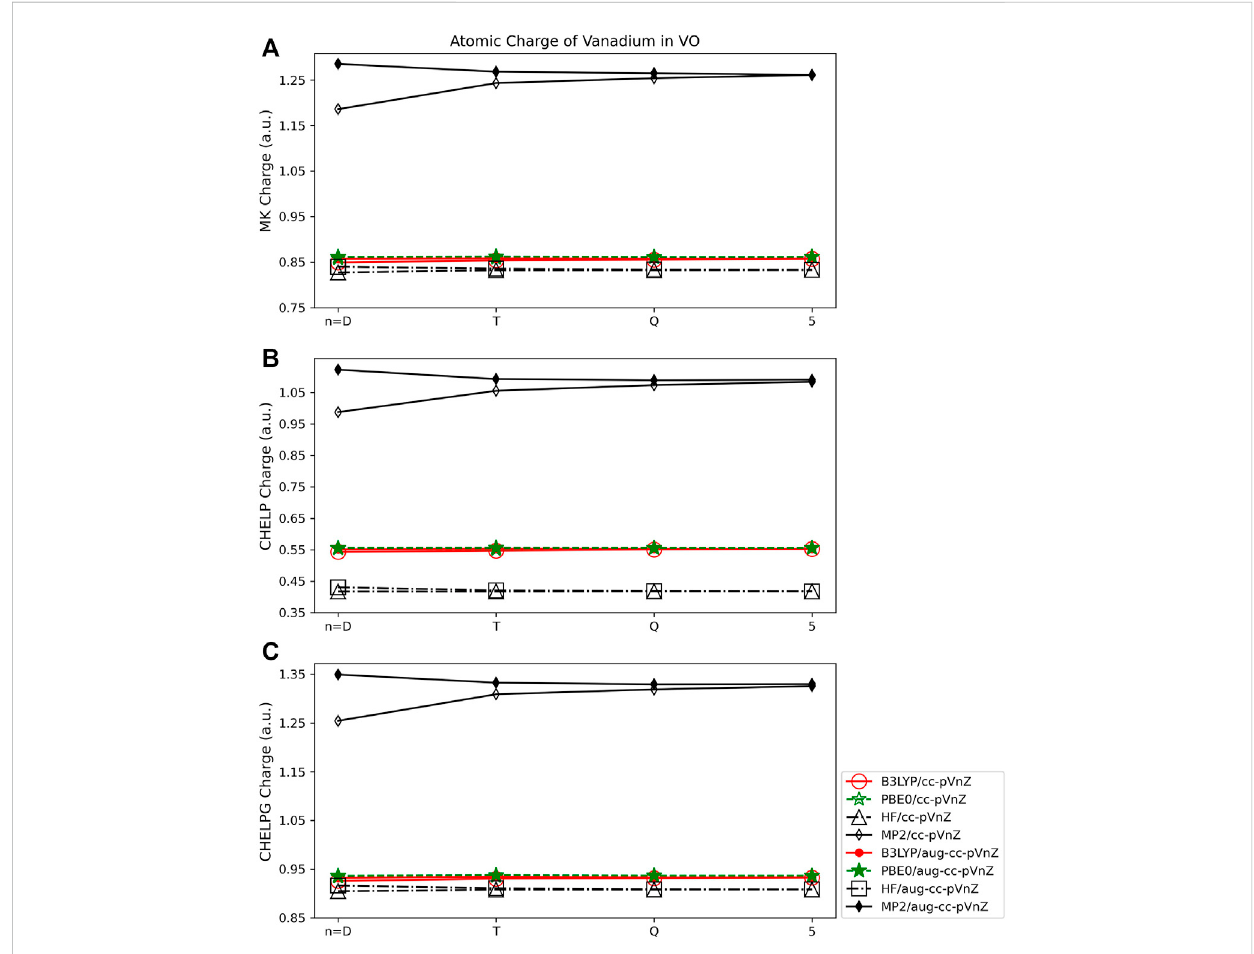
FIGURE 9 Atomic charge of vanadium in VO determined using a number of theoretical methods, basis sets, and population analysis methods: (A) Merz- Kollman, (B) CHELP, and (C) CHELPG (*Note that scales vary from one analysis method to another.).